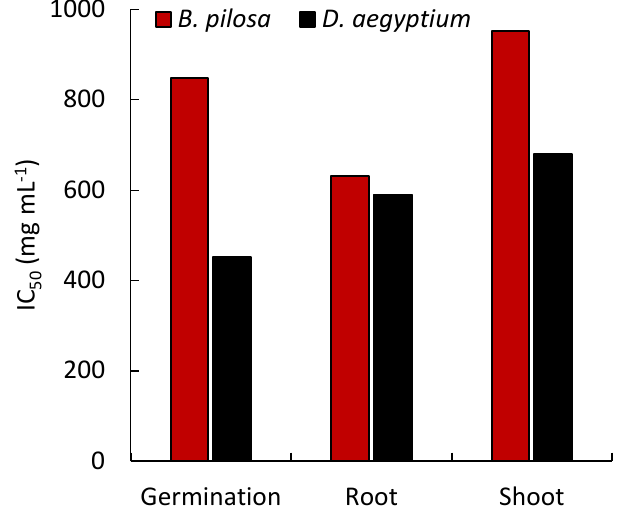
Figure 4. IC 50 values of the essential oil extracts from the above-ground parts of Pulicaria somalensis (Shie) on germination, root, and shoot growth inhibition of Dactyloctenium aegyptium (crowfoot grass) and Bidens pilosa (hairy beggarticks).